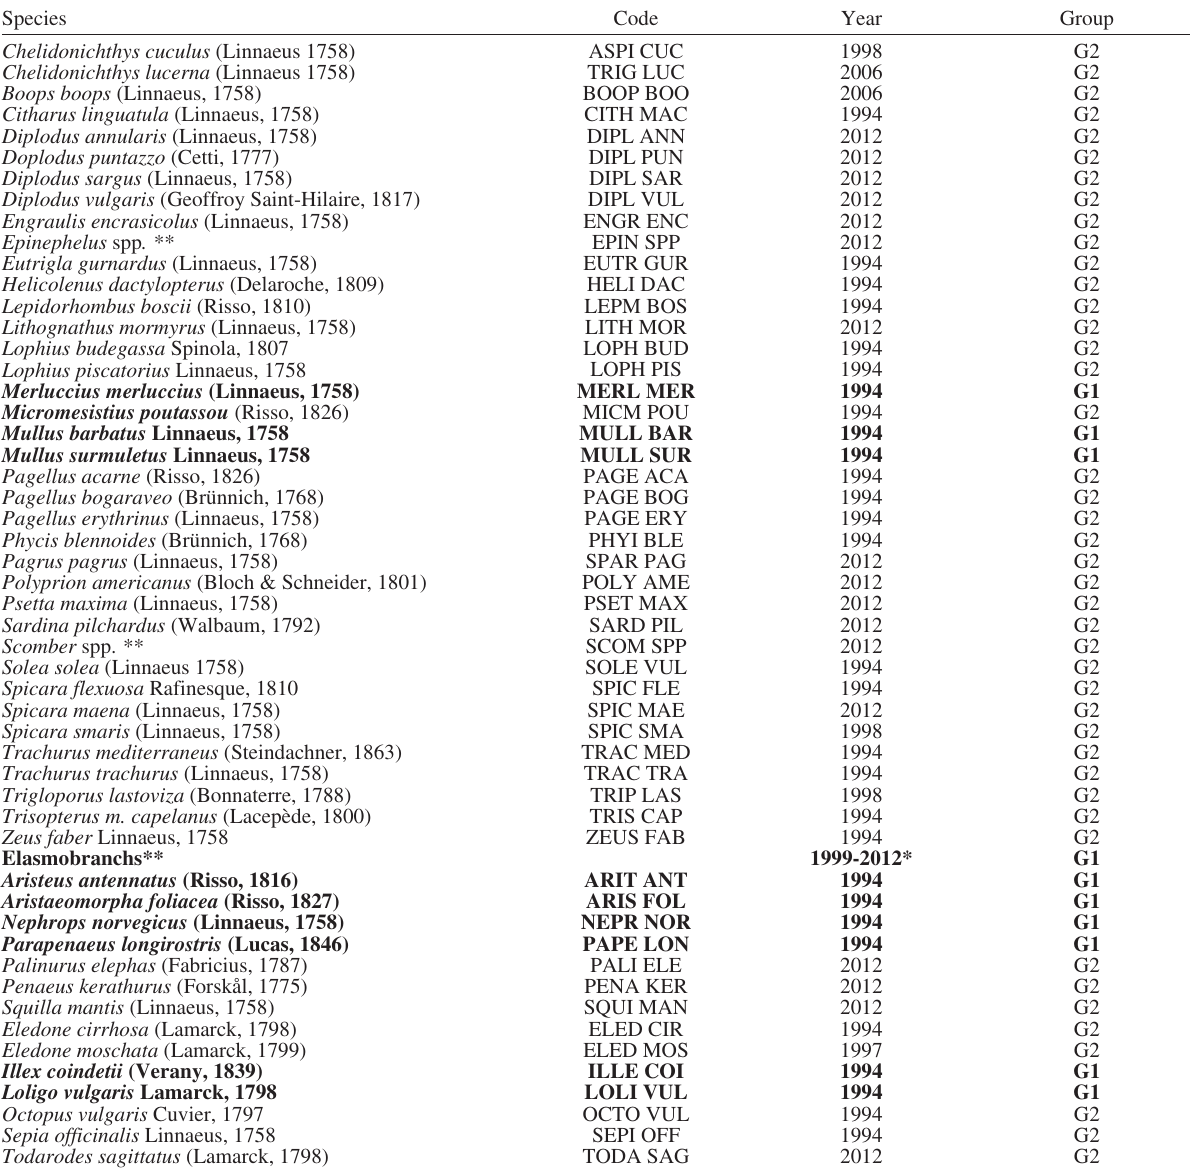
Table 3. – Scientific name and code of the target species of the MEDITS bottom trawl surveys, year in which they started to be considered target and MEDITS group in which they were classified. Species belonging to the group G1, according to the MEDITS grouping of species, are in bold. * depending on the species; ** for brevity only the genus is reported (or the group of species in the case of the elasmobranchs), but the single species of the genus or of the group are considered. For further details, see Medits Handbook, Version 9 (Anonymous 2017).